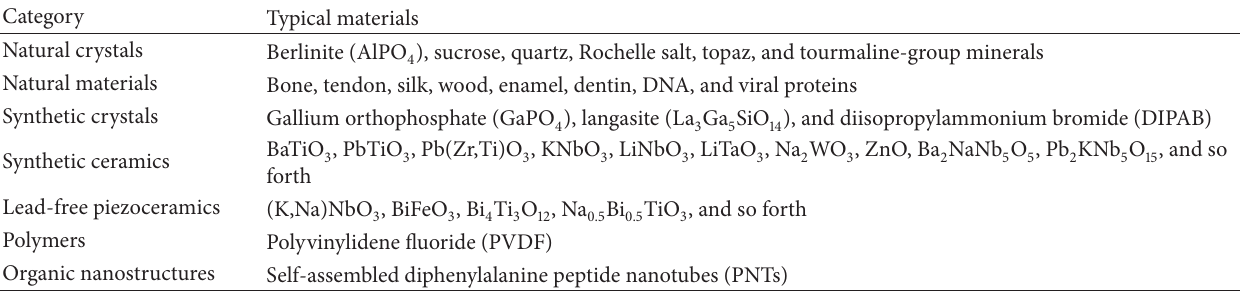
Table 1: Typical piezoelectric material in different